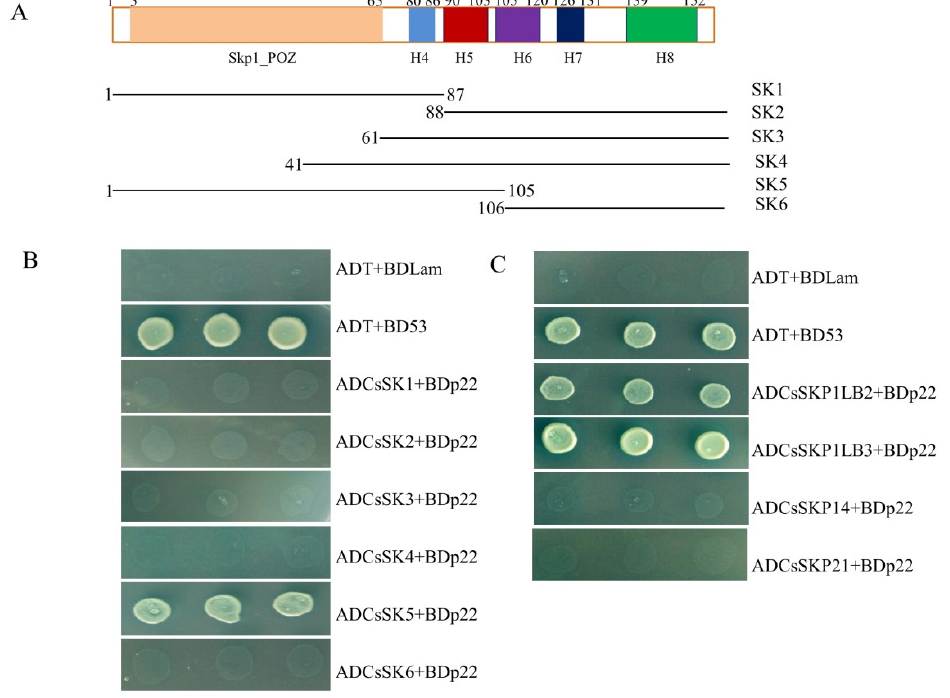
Figure 3. Determination of the interaction between p22 and cucumber SKP homologs and domains. ( A ) Schematic representation of the CsSKP1LB1 domains and deletion mutants. The POZ-domain is shown in light green, and H4, H5, H6, H7, and H8 are shown in blue, red, purple, dark blue, and green, respectively. Six deletion mutants were constructed for CsSKP1LB1 to detect the interaction domain: SK1 (residues 1–87), SK2 (residues 88–155), SK3 (residues 61–155), SK4 (residues 41–155), SK5 (residues 1–105), and SK6 (residues 106–155). The black lane is representative of the remaining part of the protein. ( B ) Growth of Y2HGold yeast cells co-transformed with BDp22 and the six CsSKP1LB1 deletion mutants (SK1, SK2, SK3, SK4, SK5, and SK6) on a high-stringency selective medium (SD / -Leu / -Trp / -His / -Ade / Aba / X- α -Gal). ( C ) Growth of Y2HGold yeast cells co-transformed with BDp22 and AD vectors containing five cucumber SKP homologs (SKP1LB1, SKP1LB2, SKP1LB3, SKP14, and